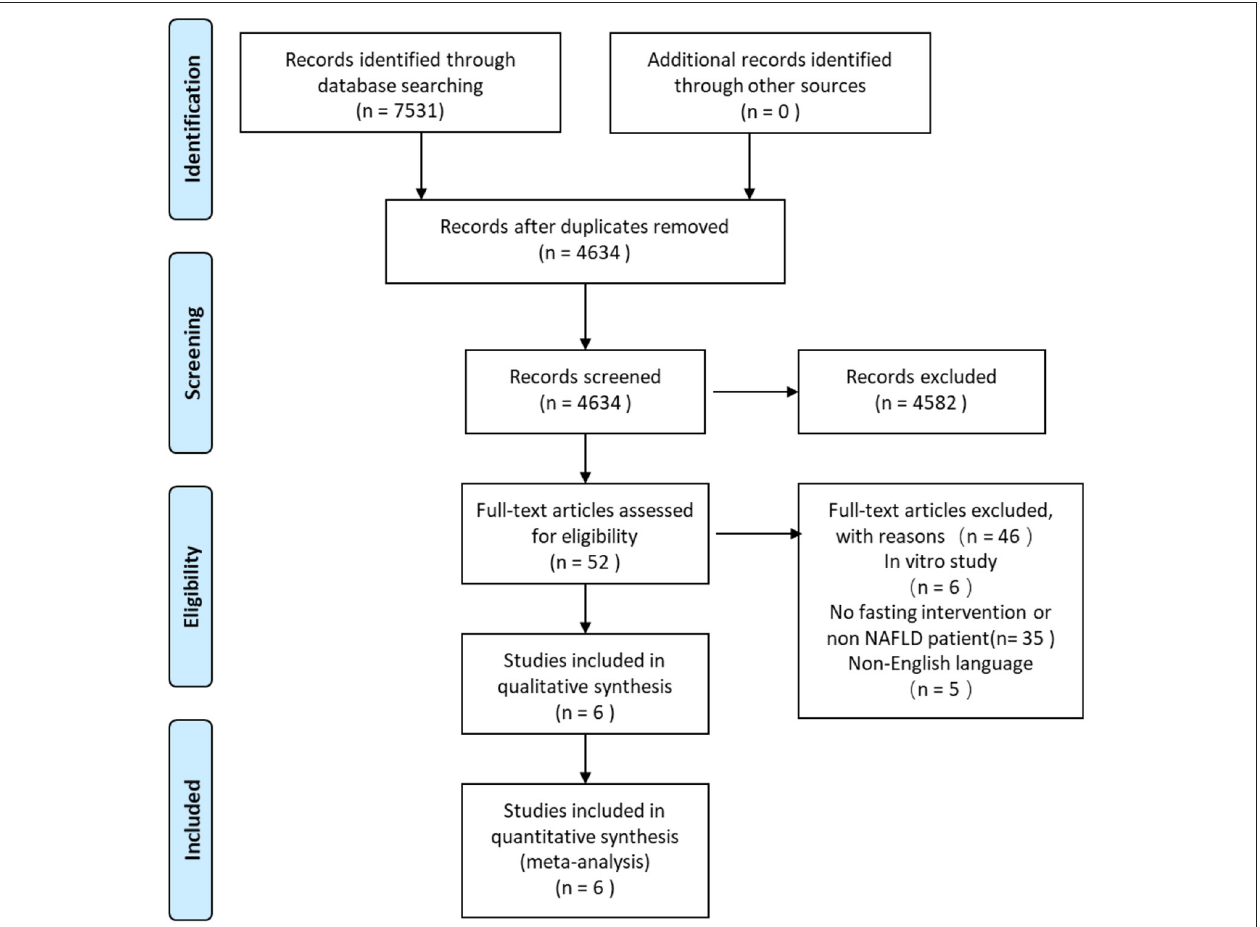
FIGURE 1 | Preferred reporting items for systematic reviews and meta-analyses (PRISMA) flow diagram for screening and selection process of studies.